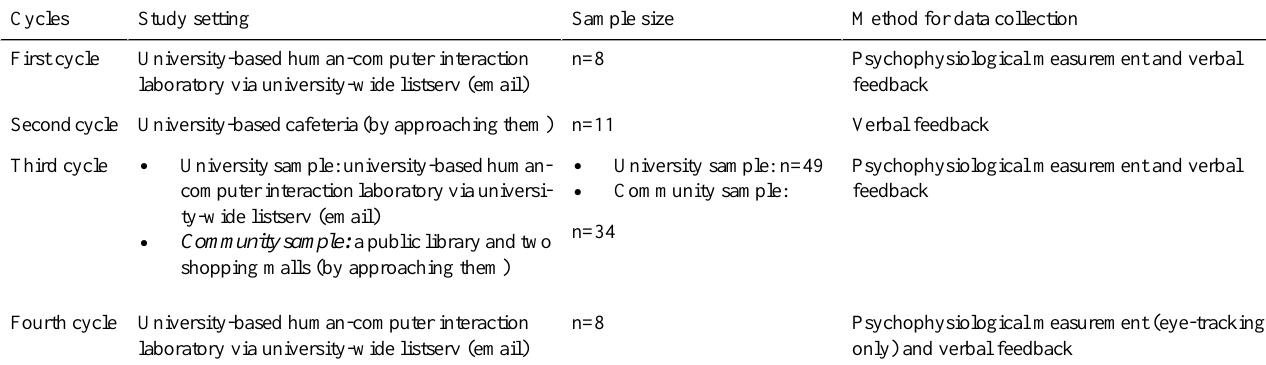
Table 1. Summarized study